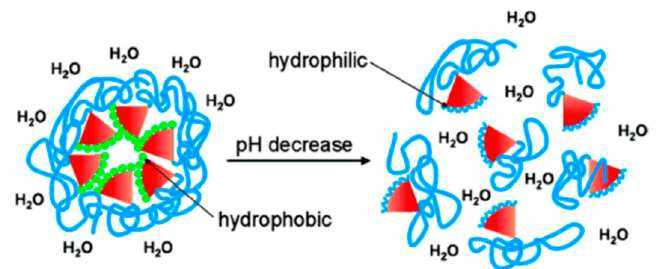
Figure 38. Linear-dendritic architectural copolymer micellar disassembly triggered by pH change. Reprinted with permission from [112]. Copyright 2004 American Chemical Society.